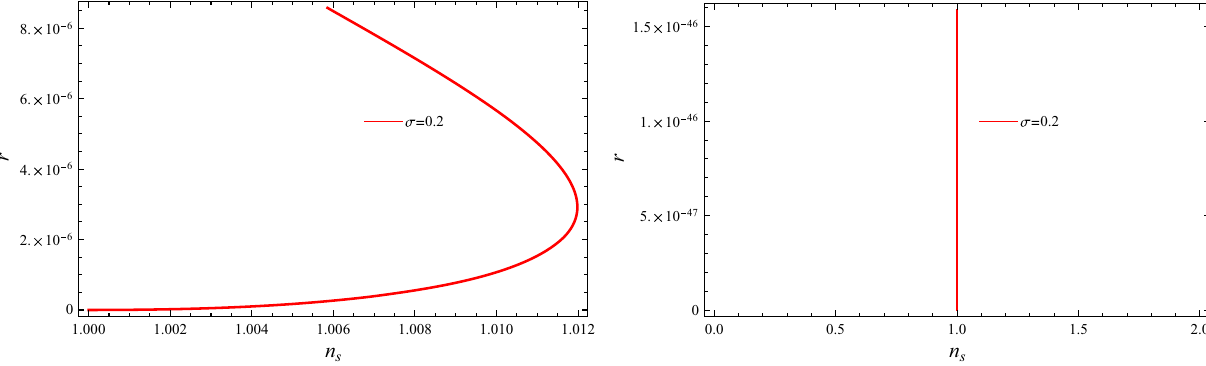
Fig. 15 Plot of r versus n s for GCCG model in weak (left panel) and strong (right panel) dissipative regimes for positive potential with n = − 2